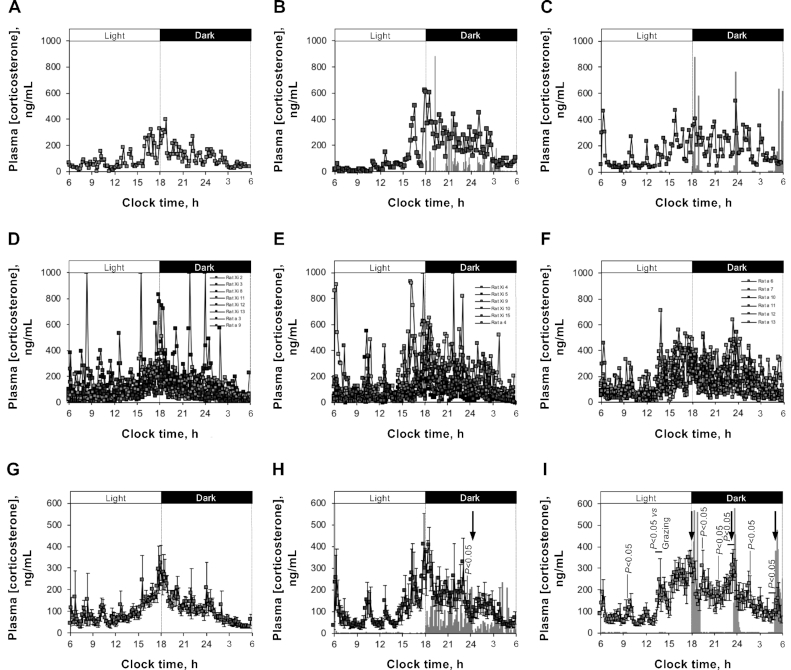
Effect of ad libitum, grazing, or meal feeding with StD on corticosterone secretion in male rats (study 3). Data shown are representative (A–C), superimposed (D–F), and mean ± SEM (G–I) 24-h corticosterone profiles from male Sprague-Dawley rats on day 20–21 of receiving StD in either ad libitum (A, D, G; n = 8), grazing (B, E, H; n = 6), or meal-fed (C, F, I; n = 6) patterns. Statistical comparisons were made by 1-factor ANOVA and Kruskal-Wallis and Dunn's multiple-comparison post-hoc tests (G–I); P < 0.05 compared with ad libitum–fed animals unless otherwise stated. Corresponding individual (B, C) and mean (H, I) feeding event data are shown in the background. Arrows show a coordinated decline in corticosterone concentration and feeding (H) and coordinated peaks of corticosterone secretion and feeding (I). StD, standard nonpurified rodent diet.